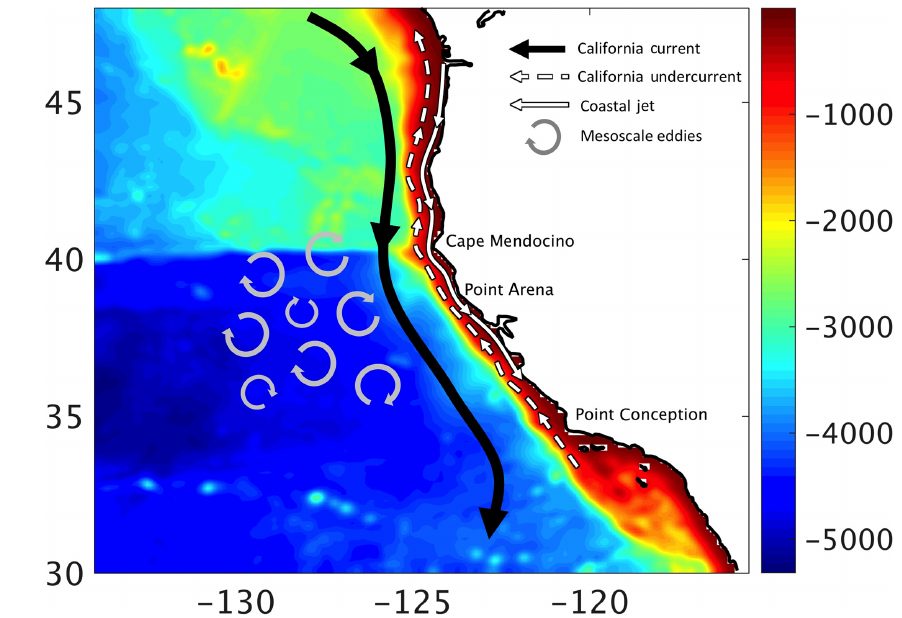
Figure 1. The model domain and bathymetry used in the present study. A schematic representation of some of the important circulation features is also